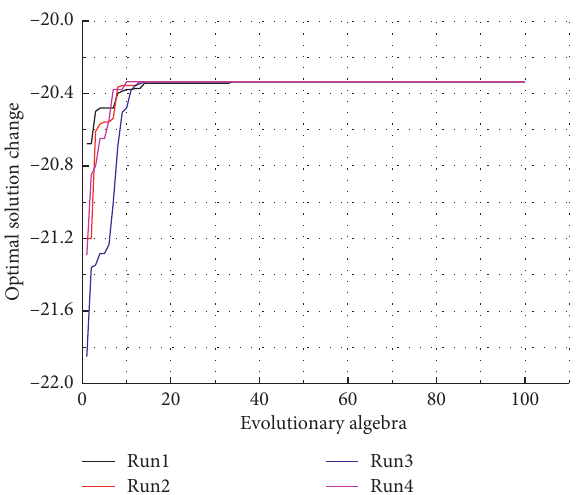
Figure 5: The evolutionary process diagram of the improved multipopulation genetic algorithm running 4